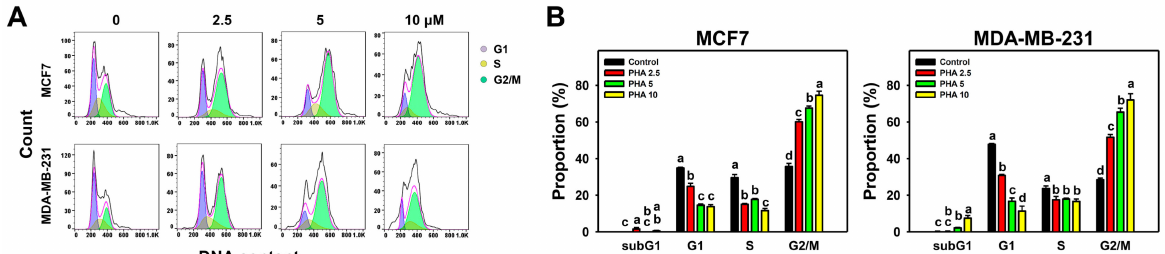
Figure 2. PHA redistributed the cell-cycle phases of two breast cancer cell lines. ( A , B ) Cell-cycle phase patterns and statistical analysis for concentration responses to PHA. Cells were incubated with PHA (0 (0.05% DMSO as control), 2.5, 5, and 10 µ M) for 24 h, i.e., control, PHA 2.5, PHA 5, and PHA 10. Data, means ± SDs ( n = 3 independent experiments). Experiments without the same top-labeled letters indicate significant changes according to multiple ANOVA comparisons ( p < 0.05 to